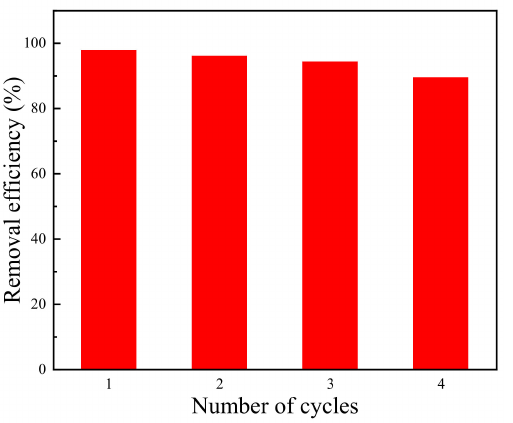
Figure 7. Regeneration of Cu-ZIF-8-1 for OFX adsorption ( c 0 = 45 mg · L − 1 ).